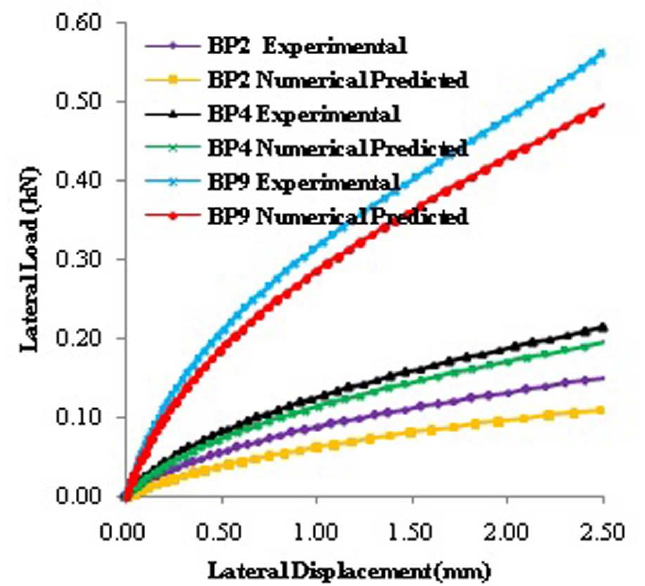
Fig. 10. Comparison between the experimental predicted lateral load results at 3D pile spacing bamboo pipe piles in dense sand layer for slenderness ratio as